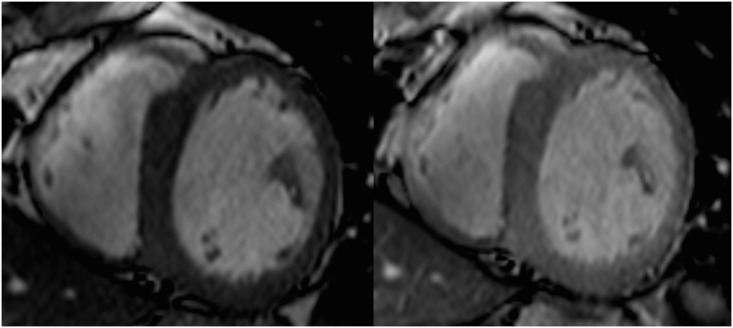
LV short axis cine b-TFE slice in the telediastolic phase before (left) and after (right) gadolinium contrast injection.